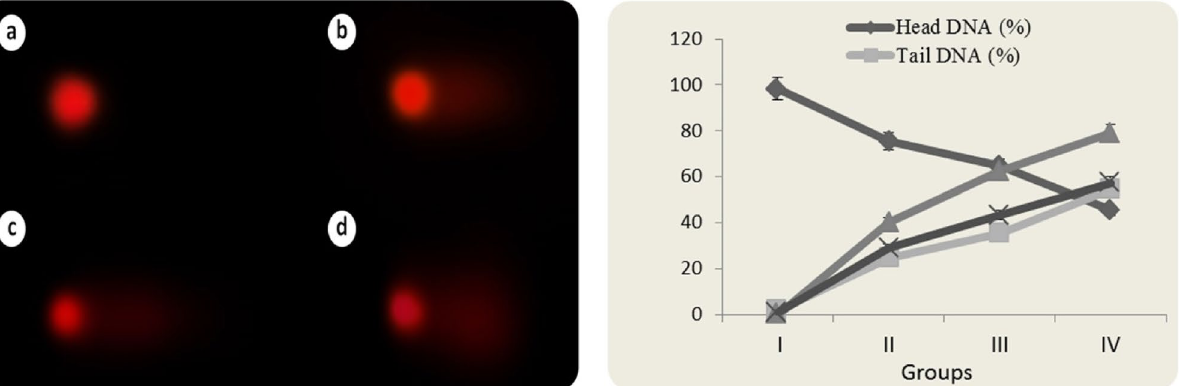
Figure 6. Comet assay analysis in leukocyte cell nucleus of cypermethrin-treated mice ( a control, b 62.5 mg/kg b.w cypermethrin, c 125 mg/kg b.w cypermethrin, d 250 mg/kg b.w